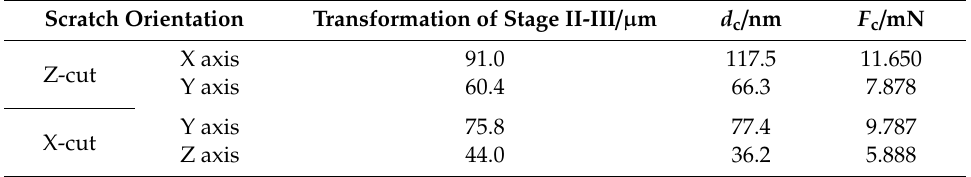
Table 1. Brittle-ductile transition critical depth and critical load of di ff erent orientations.